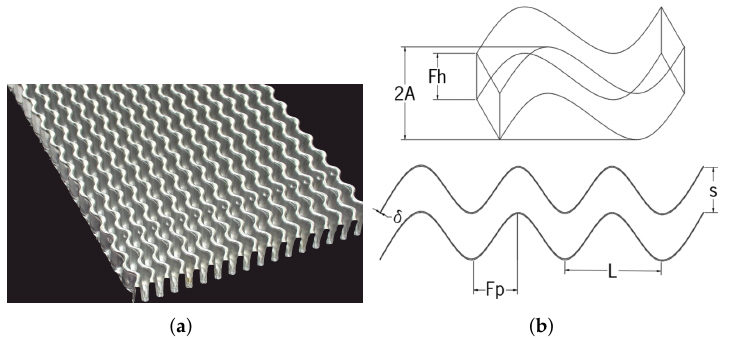
Figure 2. Compact heat exchanger: ( a ) WFs image [17]. ( b ) Wavy fin geometry parameters: Fin pitch (Fp); fin high (Fh); fin spacing (s); fin thickness ( δ ); fin wavelength (L); twice the amplitude (2A). Wavy Fins Empirical Correlations for Thermal